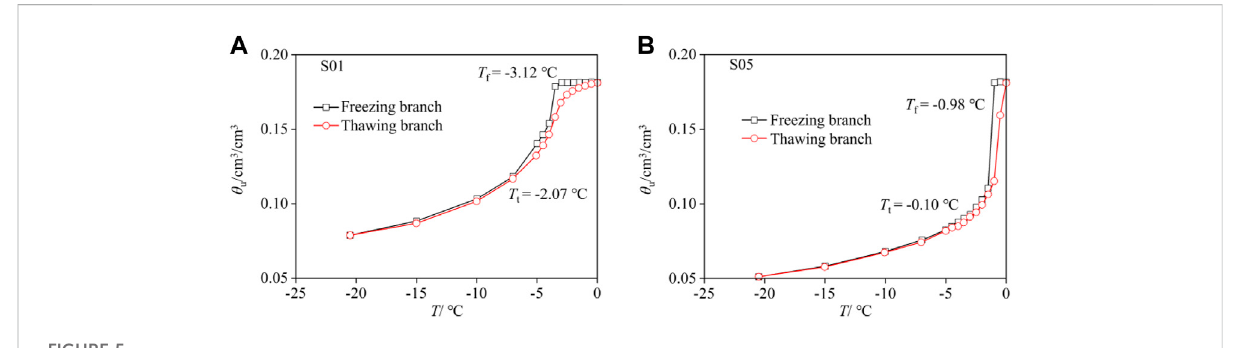
FIGURE 5 Effect of soil type on the